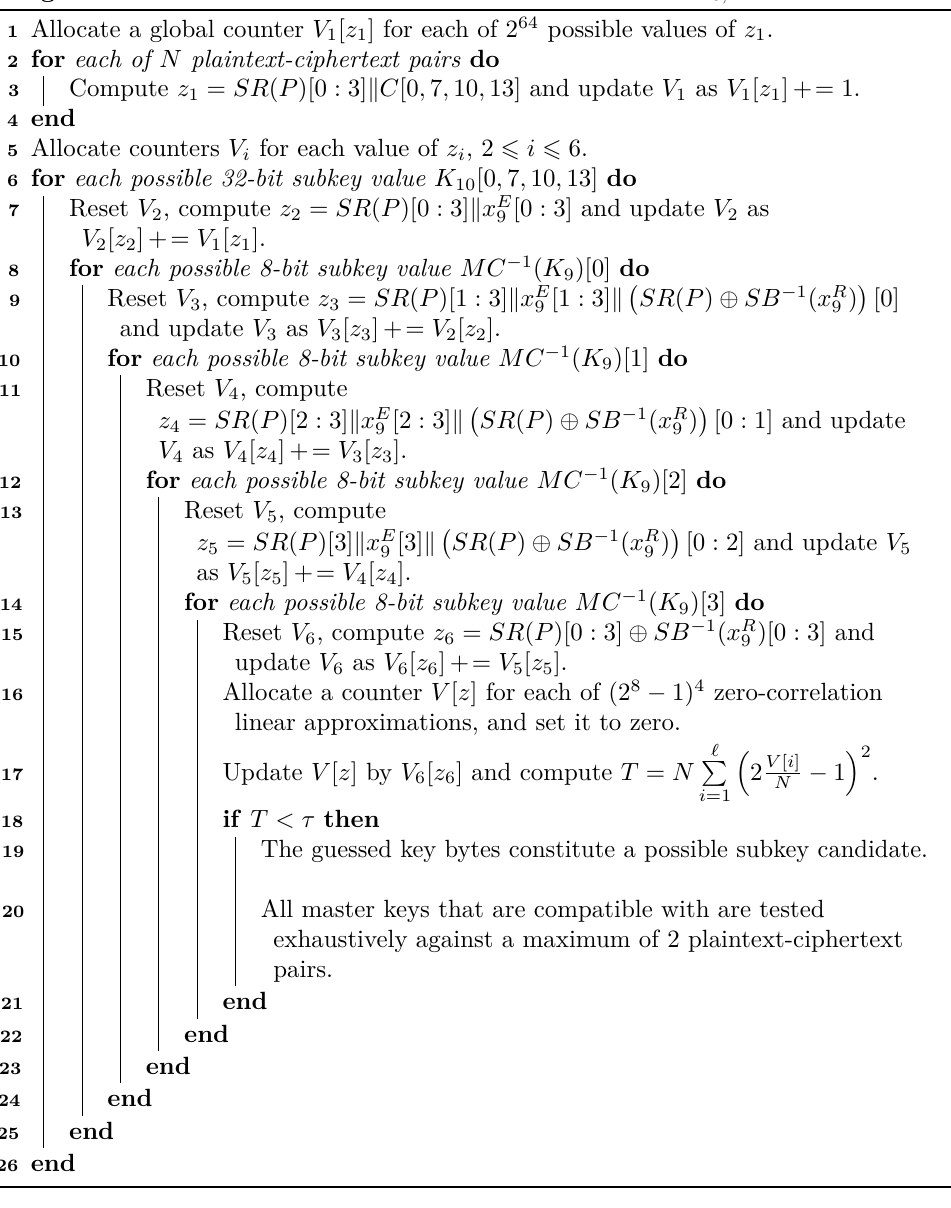
Algorithm 4: Zero-correlation linear attack on Dual-AES-PRF 8 , 2